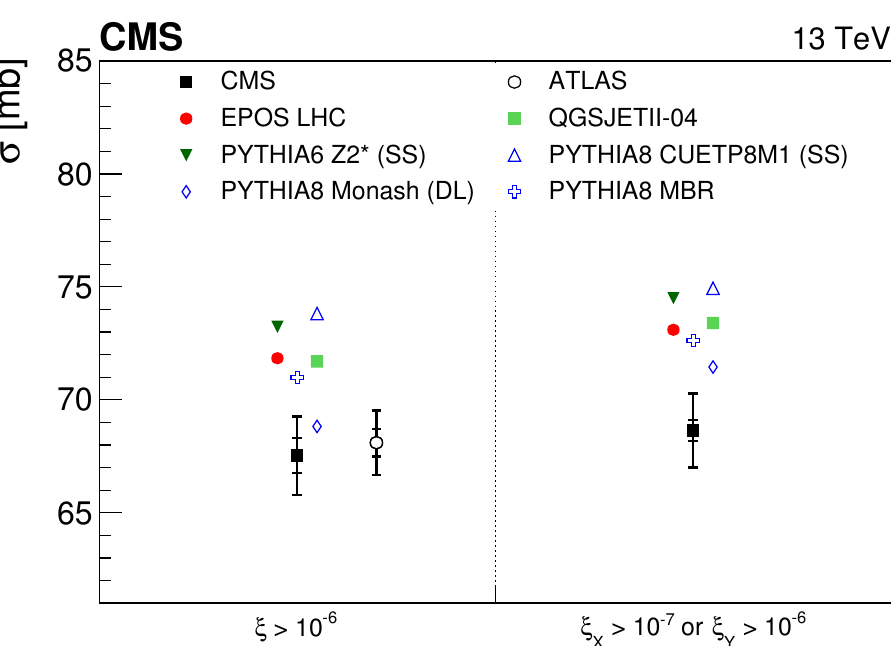
p Figure 1 . Proton-proton inelastic cross section at s = 13 TeV in two phase space regions, where (cid:24) = M 2 =s , compared to di(cid:11)erent models and to the ATLAS result. The inner error bar on the CMS and ATLAS data points indicates the systematic uncertainty only, while the full error bar re(cid:13)ects the quadratic sum of systematic and integrated luminosity uncertainties. The horizontal placement of the points within each phase space bin is arbitrary.